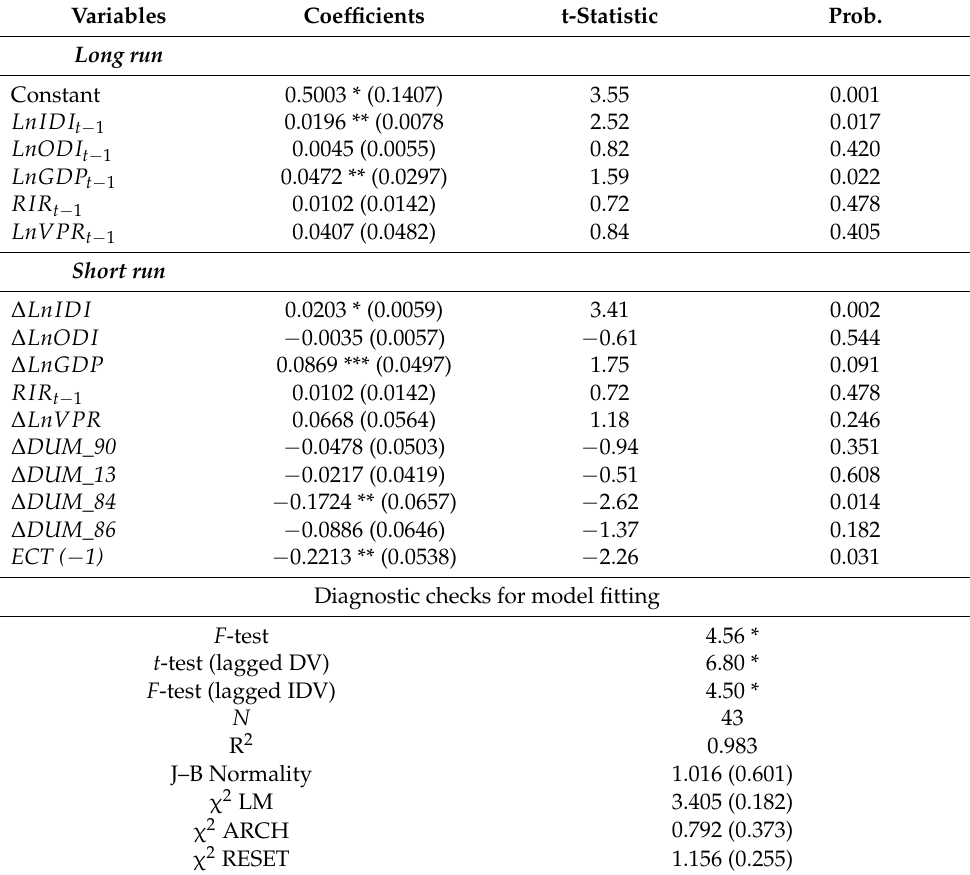
Table 5. Results of the Augmented ARDL